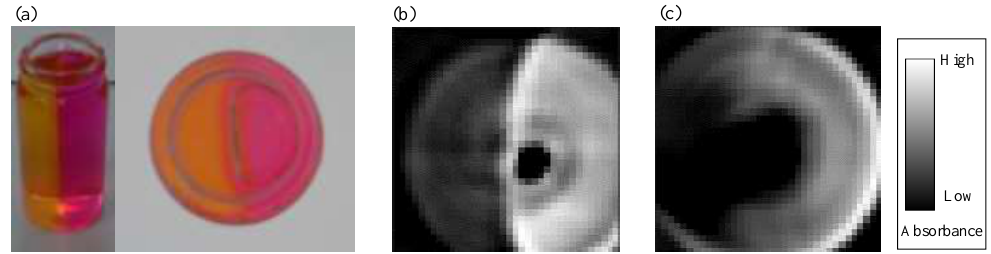
Figure 7. Experiment result on a sample with pH distribution. ( a ) An overview and a top view; ( b ) result when there is water around the sample and ( c ) when there is no water around the sample.